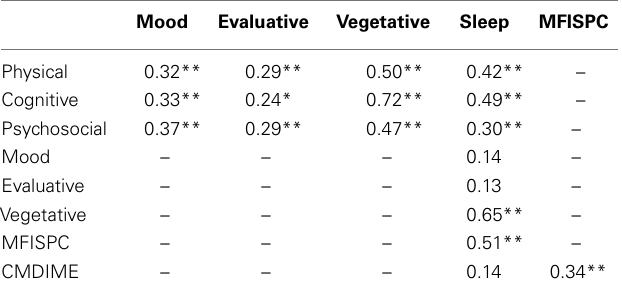
Table 3 | Correlations of fatigue, depression, and sleep disturbance .